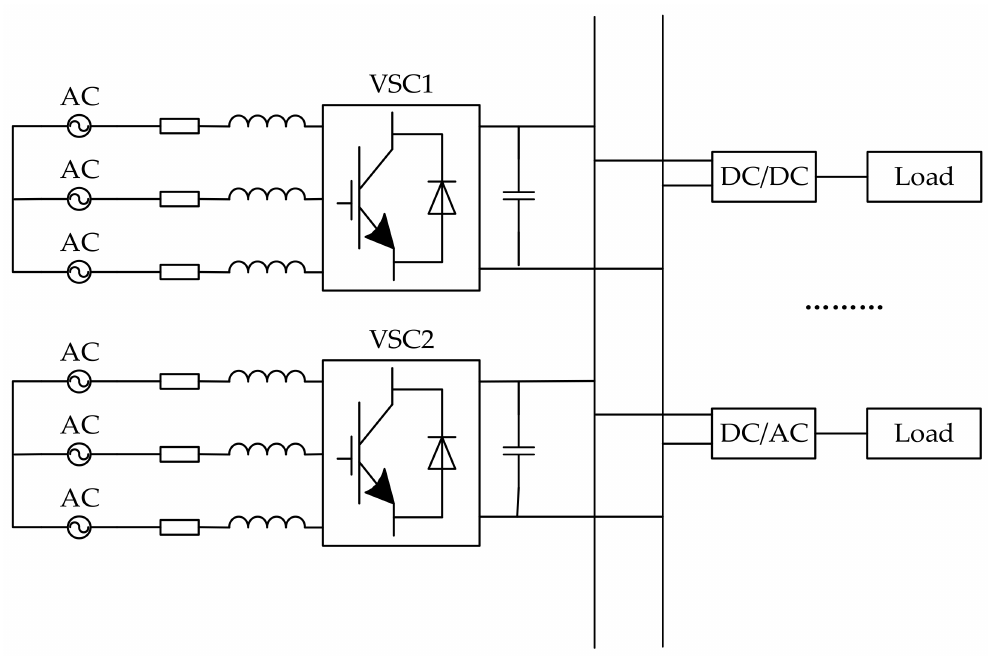
Figure 14. Simplified model of a DC distribution